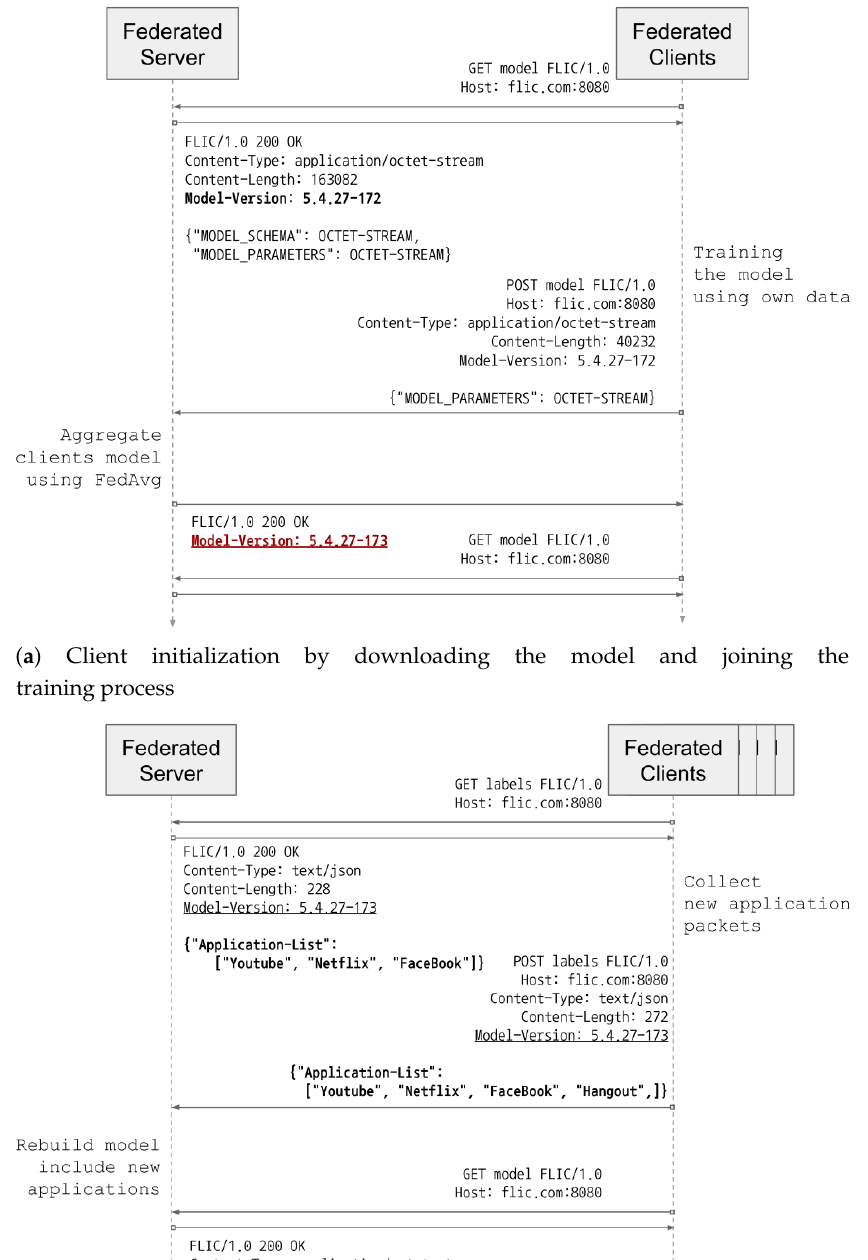
Figure 3 is the packet-to-vector image of ISCXVPN2016 data, which is widely used in Internet traffic classification studies. Figure 3 shows only the first 100 bytes of samples . Since the TCP/IP header of a packet is converted to a feature vector, the top 10 pixels are usually composed of 20 bytes in the IP header (top 5 pixels) and 20 bytes in the TCP header (next top 5 pixels), which represent the characteristics of the packet header. A vector of 365 pixels is built in the payload if there is no option in the packet header.